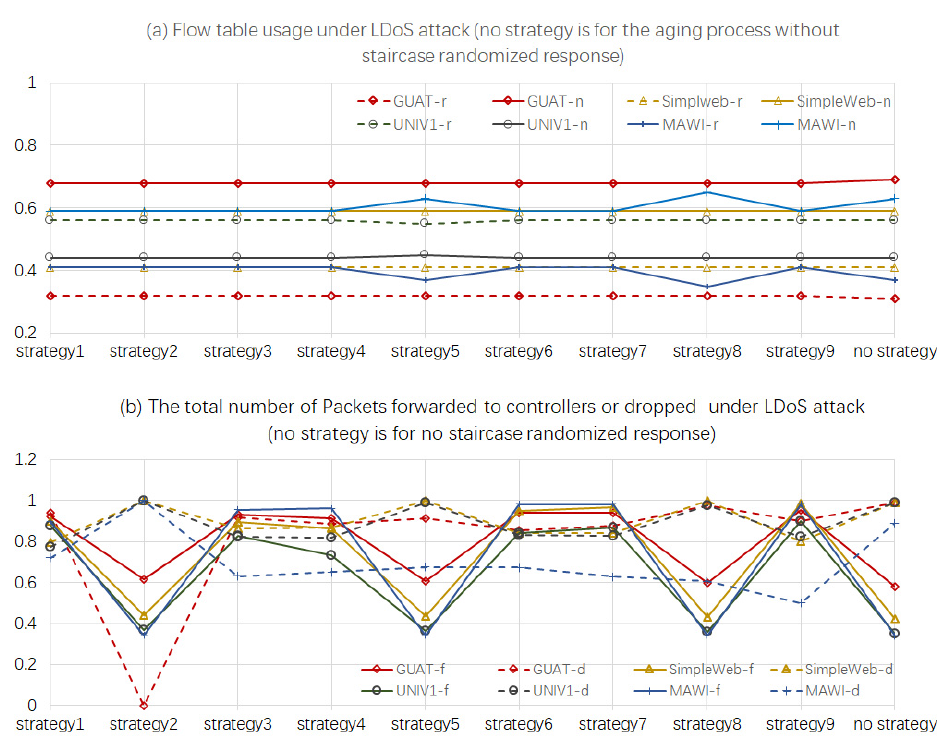
Figure 7. Applying staircase randomized response under LDoS attacks and with flow-table